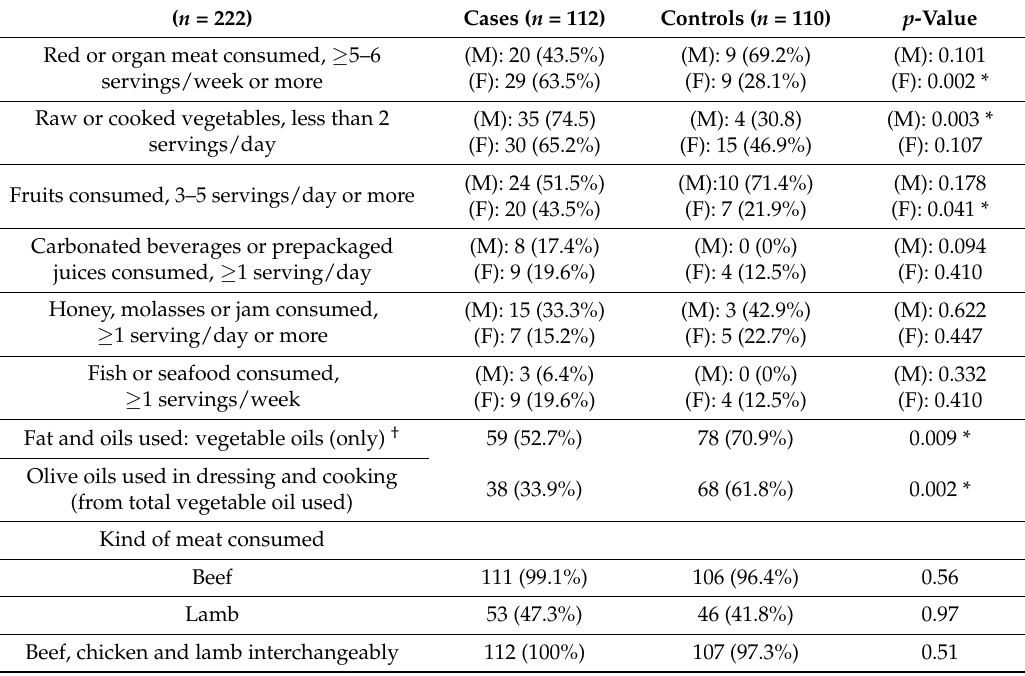
Figure 3. Distribution of participants according to the different dietary patterns, BMI, and gender. Table 7. Dietary patterns of cases and